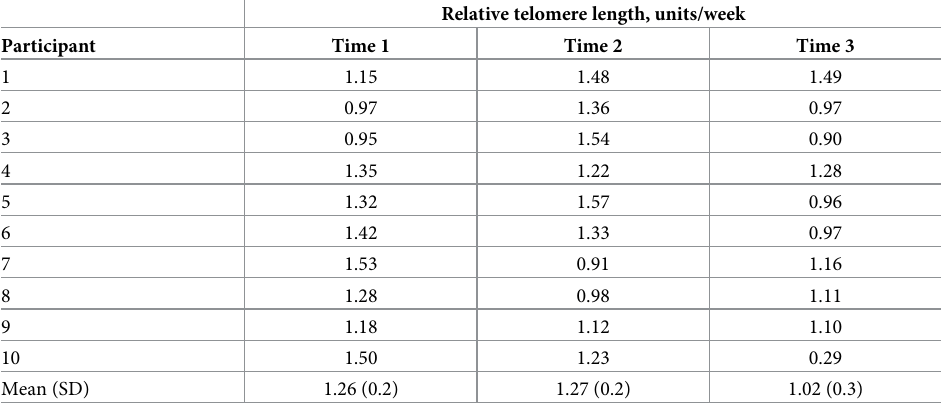
Table 2. Relative telomere length at 3 time points during the NICU hospitalization (n = 10). Relative telomere length,